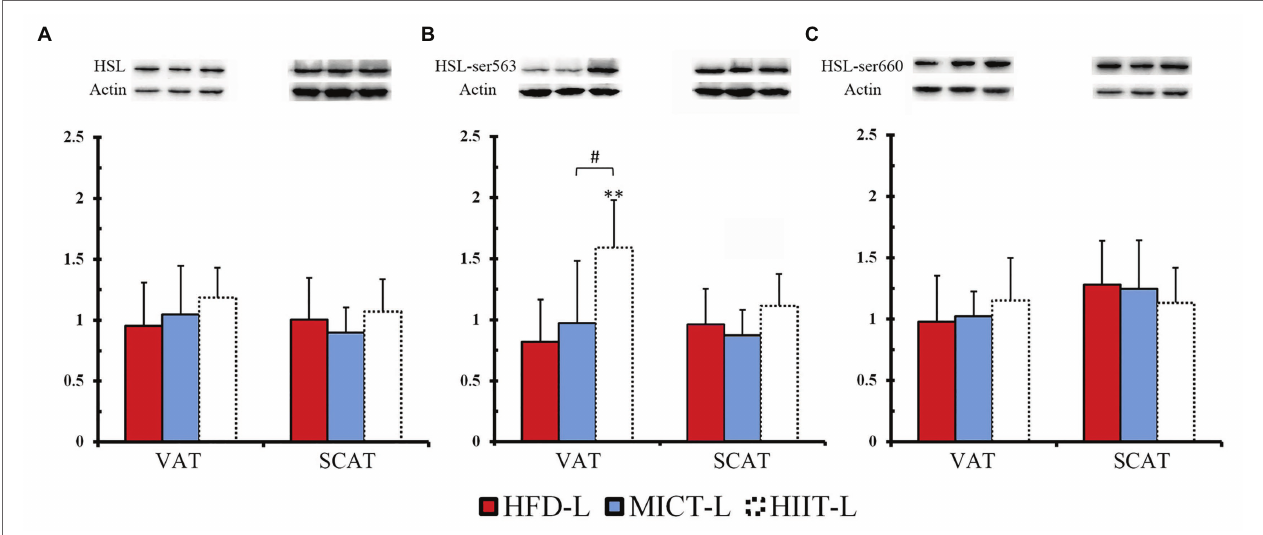
FIGURE 6 | HSL protein expression (A) , phosphorylation of ser563 (B) and ser660 (C) with 12 hours of fasting and after 12 weeks of MICT or HIIT. ** p < 0.01 vs. HFD-L; # p < 0.05 HIIT-L vs. MICT-L. Values of p were calculated by one-way ANOVA. Bands shown are representative for overall